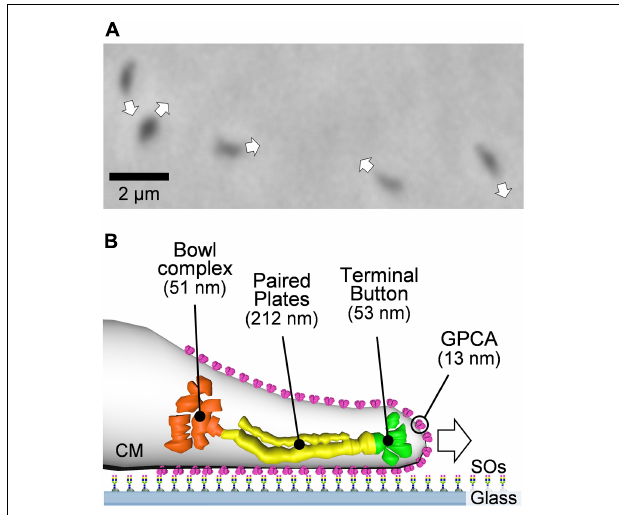
FIGURE 1 | Gliding motility of Mycoplasma pneumoniae . (A) Phase-contrast micrograph of M. pneumoniae cells. The gliding direction of cells are indicated by white arrows. (B) Illustration of gliding machinery. The gliding machinery is composed of bowl complex, paired plates, terminal button, and GPCA. The lengths along the cell axis were summarized from previous studies (Nakane et al., 2015; Vizarraga et al., 2020). GPCA, working as a leg is anchored to the cell membrane (CM) and catches sialylated oligosaccharides (SOs) fixed on solid